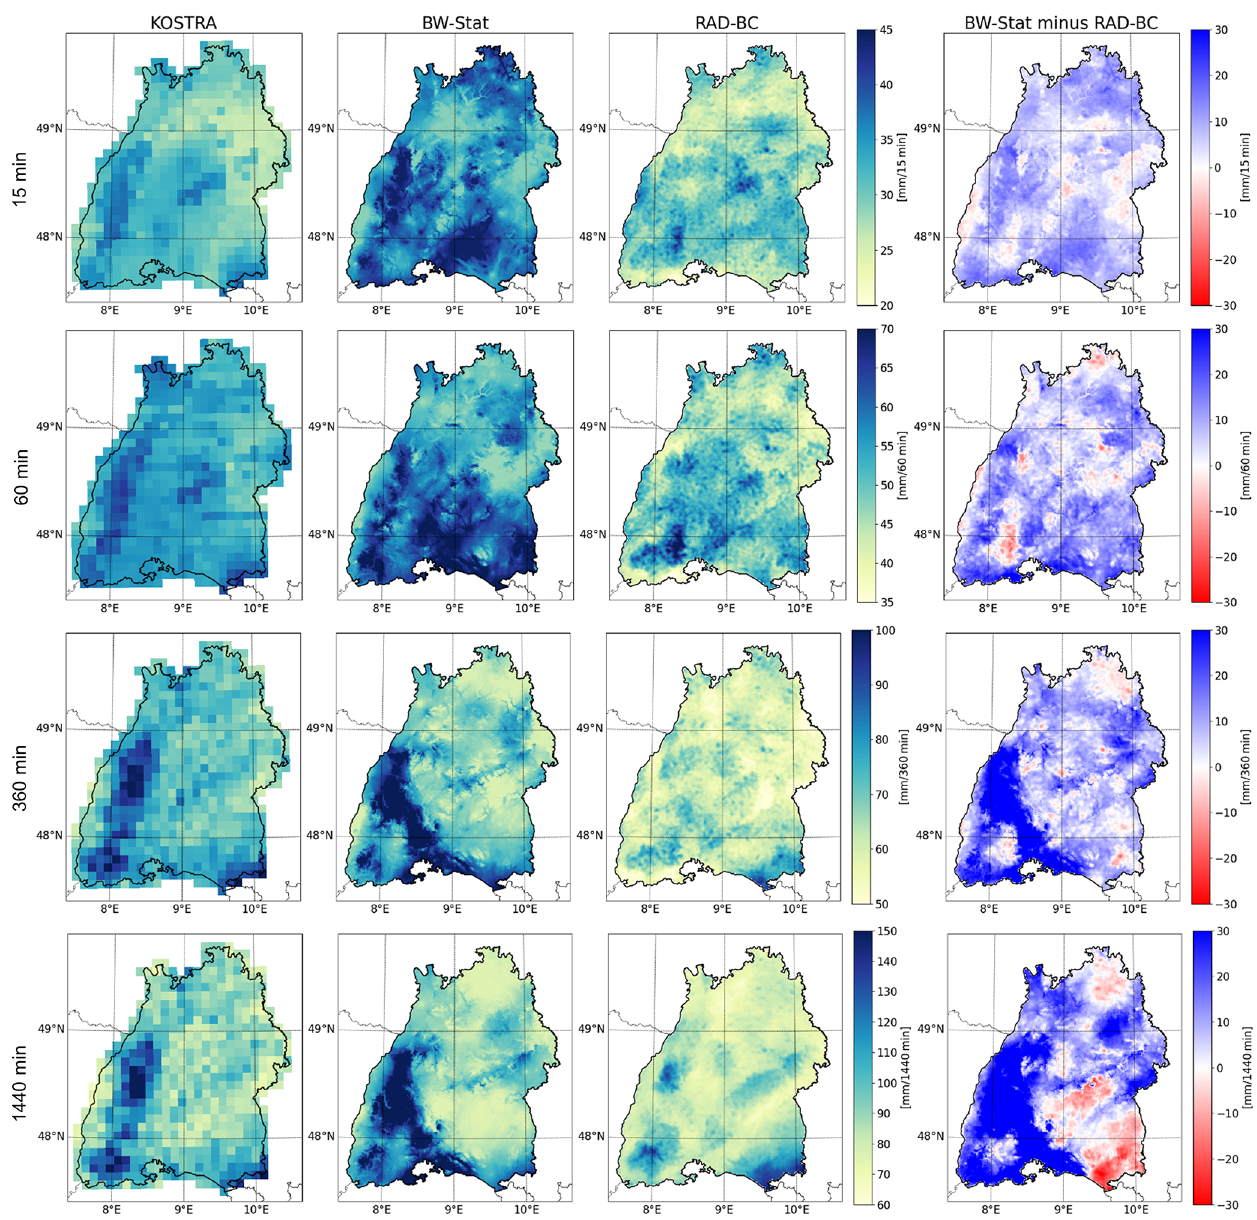
Figure 4. Magnitude of design storms with a return rate of 100 years for four different event durations (15, 60, 360 and 1440min, depicted in rows) and three different datasets (KOSTRA, BW-Stat, RAD-BC, depicted in columns). Additionally, the difference between BW-Stat and RAD-BC is depicted (right